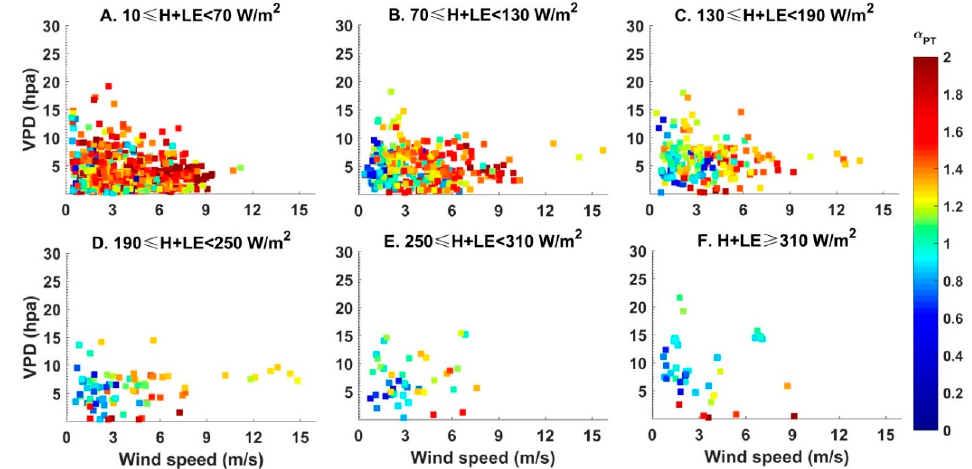
Figure 10. Distributions of 30 min scale α with respect to VPD and wind speed under a range of available energy conditions during the low ‐ water period.